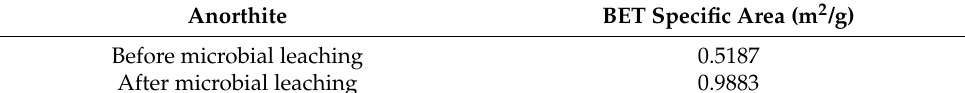
Table 4. BET surface area test results of anorthite.